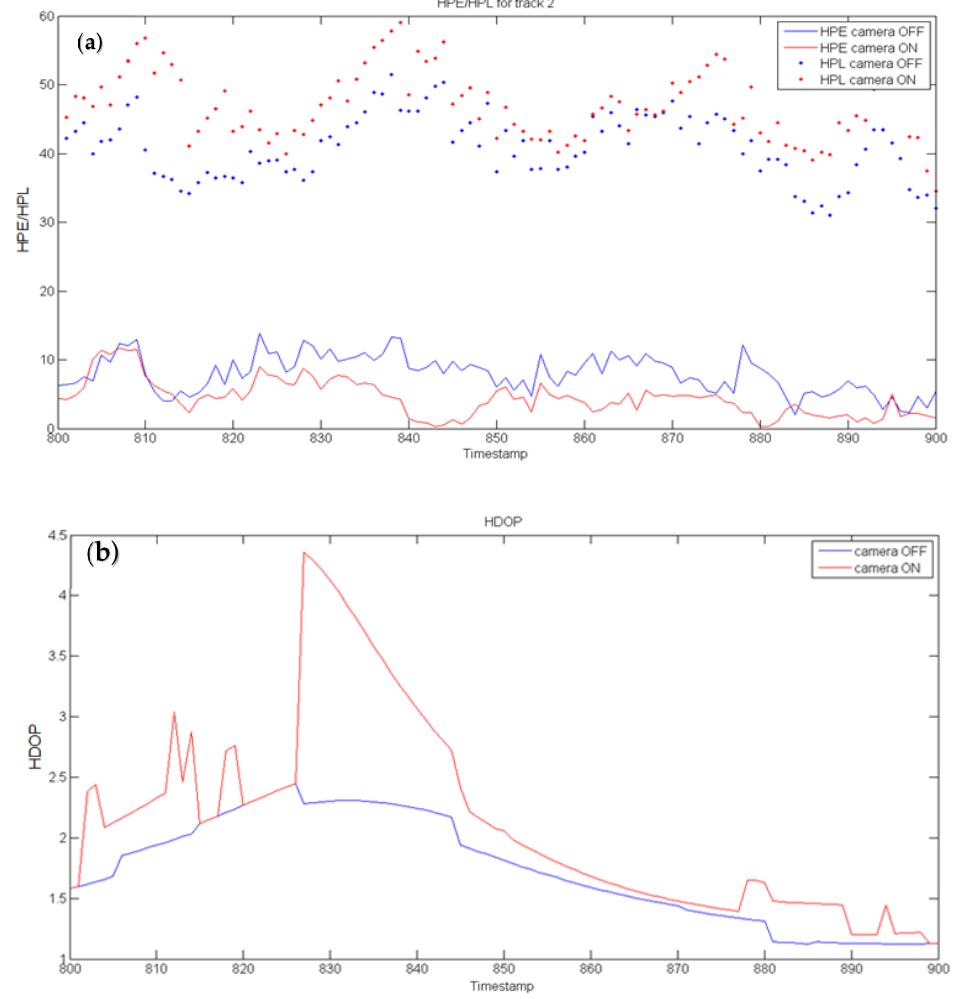
Figure 8. HPL ( a ) and HDOP ( b ) around timestamp 850.